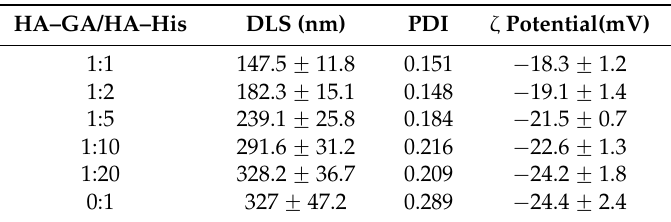
Table 1. Mean diameters and ζ potential measurements of HA–GA/HA–His mixed micelles at different rates.